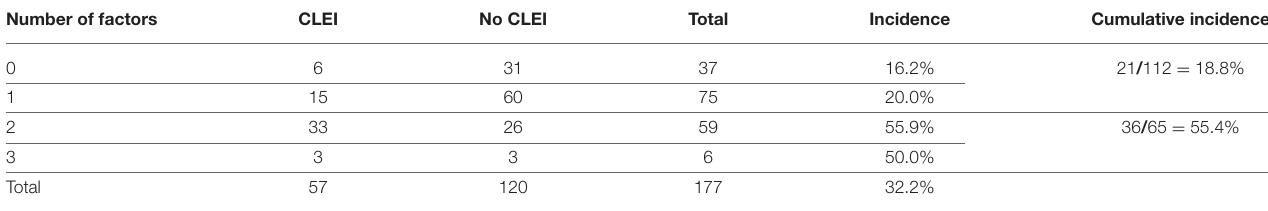
TABLE 7 | Injury incidence relative to number of risk factors. Number of factors CLEI No CLEI Total Incidence Cumulative